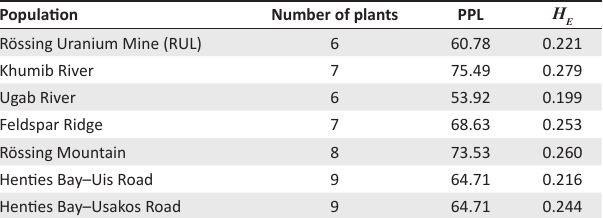
TABLE 6: Amplified fragment length polymorphism (AFLP)-based estimates of genetic variation, within each of the seven sampled Lithops ruschiorum populations, estimated as percentage of polymorphic loci and mean expected heterozygosity ( H ). E